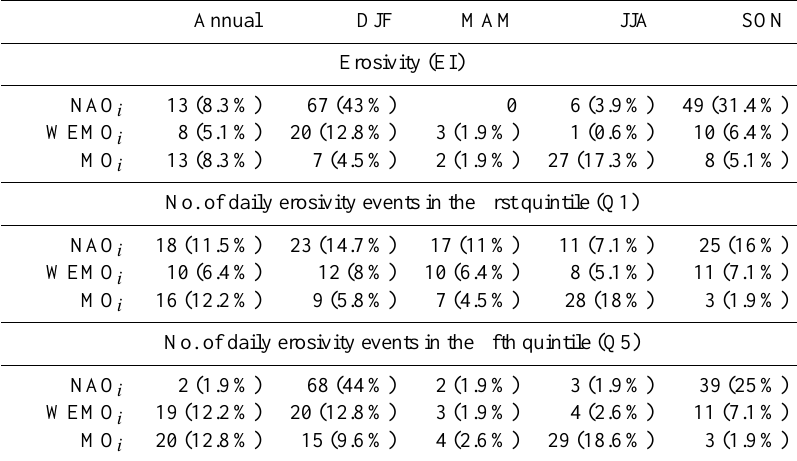
Table 4. Number of significant correlations between atmospheric circulation indices and rainfall erosivity (Pearson’s correlation test, signif- icance level α = 0 .